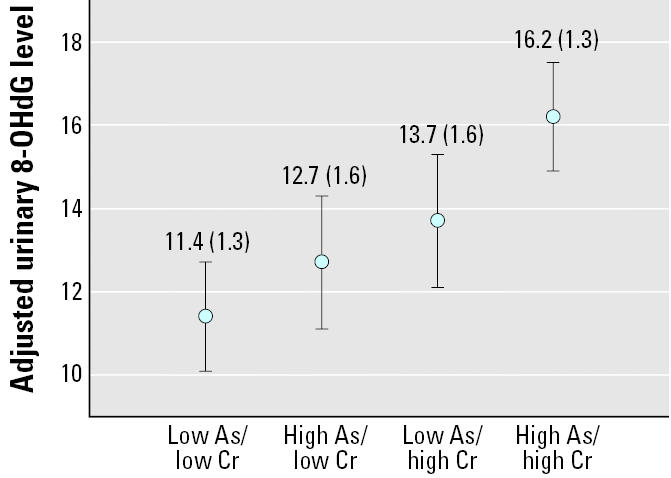
Adjusted urinary 8-OHdG level (ng/mg creatinine) by urinary arsenic and urinary chromium concentrations. Values shown are mean ± SE. Cut points were determined according to medians (arsenic, 7.7 μg/g creatinine; chromium, 2.0 μg/g creatinine) of urinary creatinine-adjusted levels among all subjects.